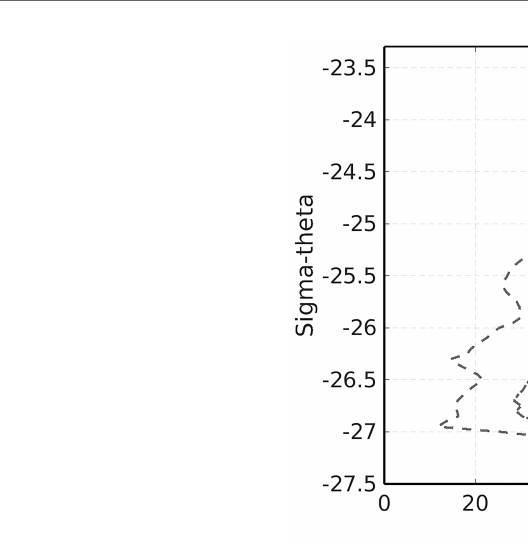
FIGURE 9 | Percentage of South Atlantic Water (SAW) estimated according to Eq. 2 for the mean NBC ring (solid line), ring A (dashed line) and for ring B (dotted- dashed line), considering only pro fi les located within 1R from the ring